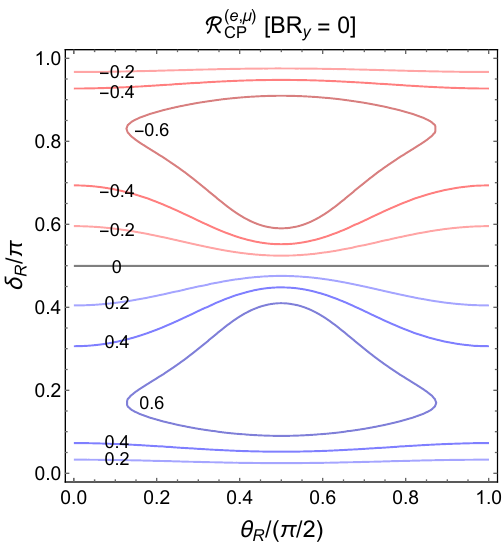
( e;(cid:22) ) as functions of the RHN mixing angle (cid:18) R and CP R = 10 TeV for concreteness, but the R for BR y = 0. R